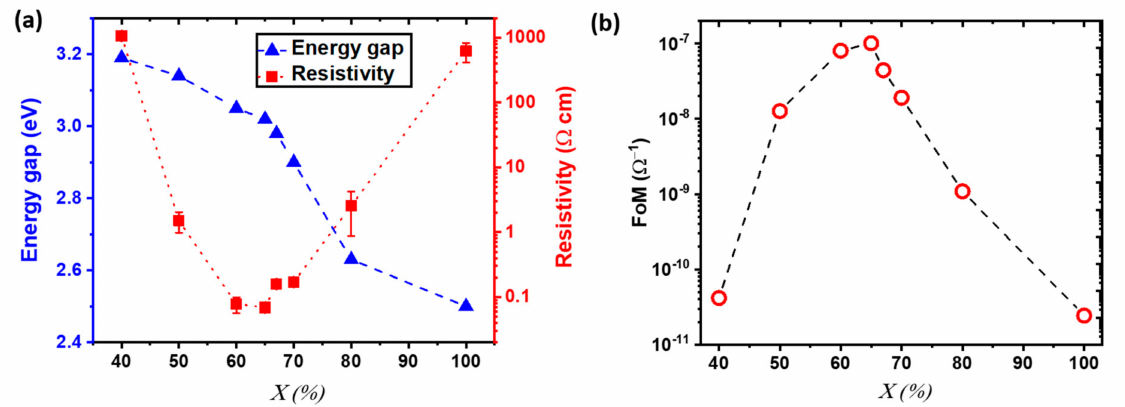
Figure 2. Electrical properties, energy gap, and Figure of Merit for out of stoichiometry CuCrO 2 thin films. ( a ) Evolution of (left axis) the energy gap (blue triangles) as estimated by Tauc plot, and (right axis) the resistivity values (red square and the relative error is reported as red line) as a function of the copper cationic ratio in the solution, X . ( b ) Hackee’s figure of merit (FoM) as a function of X